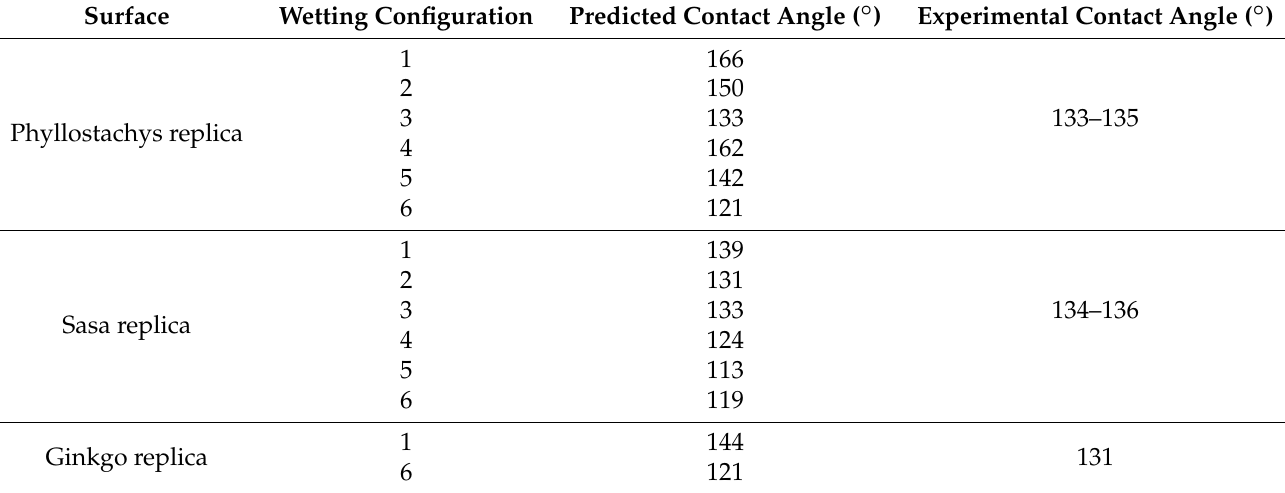
Table 4. Predicted contact angle of the wetting